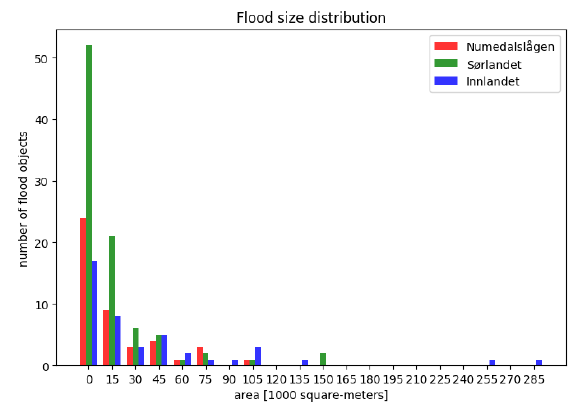
Figure 3. Flood size distribution (m 2 ) of flood objects for the three flood